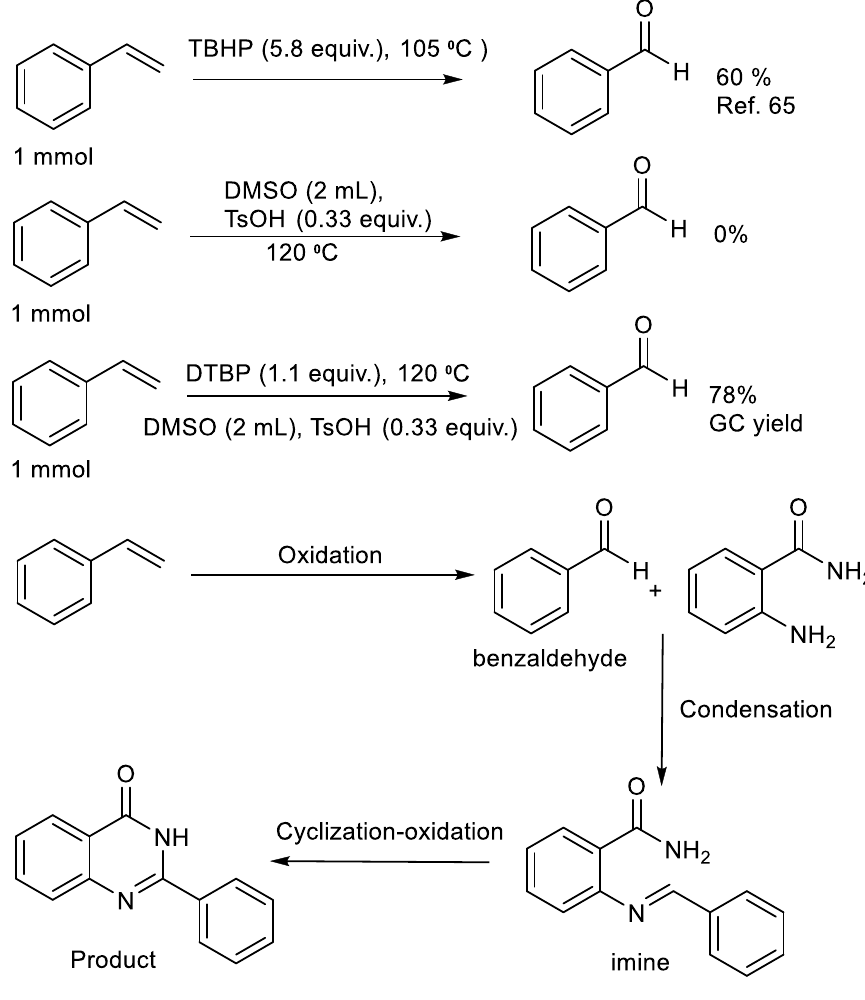
Figure 5. Control experiment and proposed mechanism.